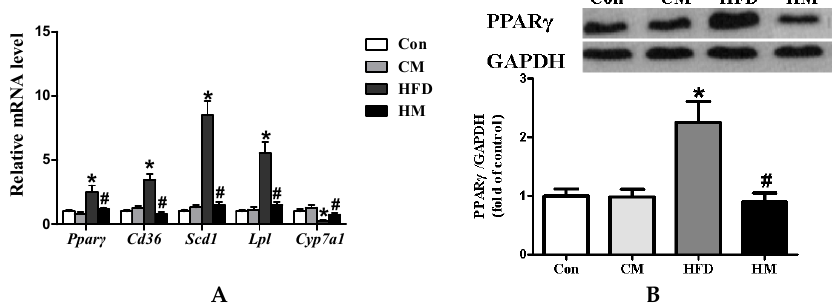
Figure 4. Myricetin normalized expressions of genes involved in lipid metabolism ( A ) and decreased protein expression of hepatic PPAR γ ( B ). Values were presented as mean ± SEM ( n = 8). Con, control diet; CM, control diet with additional 0.12% myricetin; HFD, high-fat diet; HM, high-fat diet with additional 0.12% myricetin. * p < 0.05 vs. the Con group; # p < 0.05 vs. the HFD group.